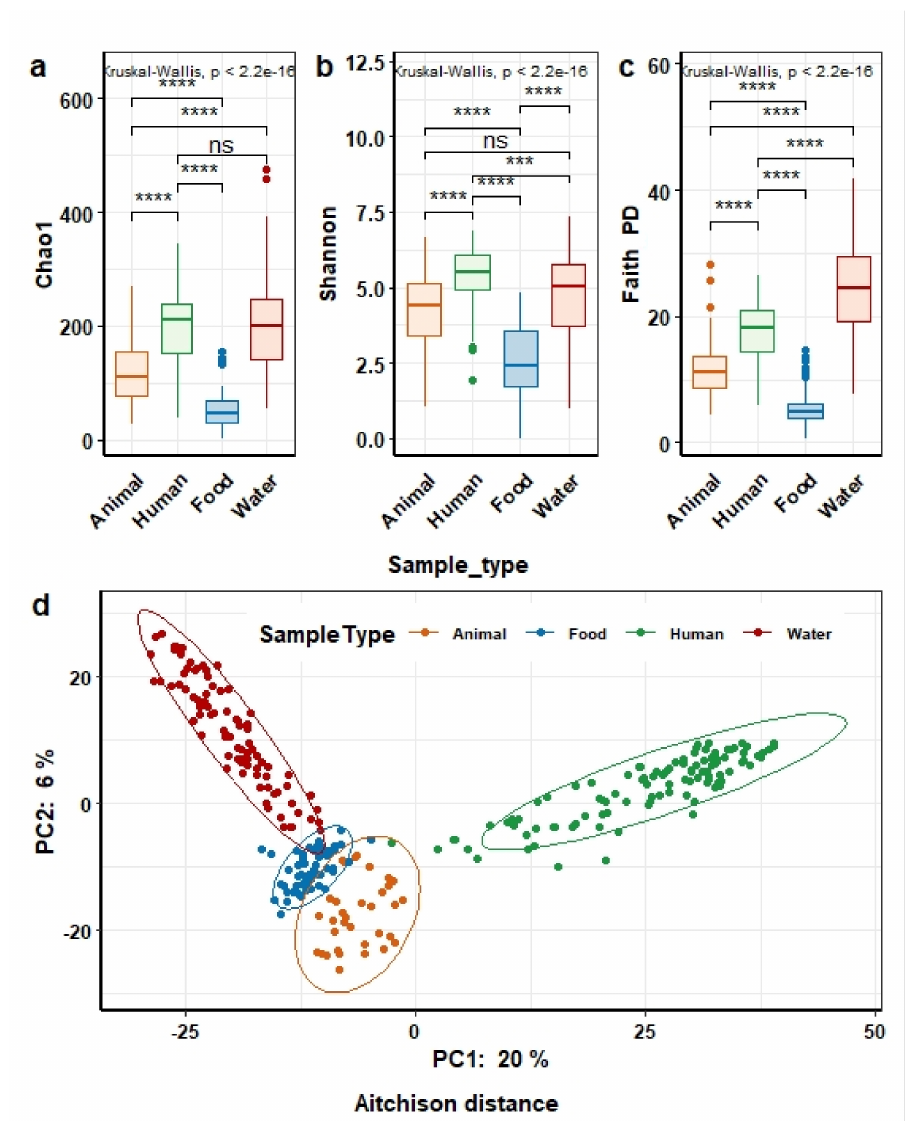
Figure 6. Microbial composition of human and animal gut, water, and food. Differences in estimated microbial richness (Chao1) ( a ) and diversity (Shannon ( b ) and Faith’s PD ( c )) across sample types. Kruskal–Wallis test followed by Wilcoxon test for post hoc comparisons of four sample types (humans, animals, food, and water). *** p < 1 × 10 − 3 , **** p < 1 × 10 − 4 . ( d ) Principal component analysis (PCA) based on Aitchison distance. Each point represents the microbial community structure of an individual animal stool (orange), human stool (green), food (dark blue), and water (red) sample. (PERMANOVA test, p value < 1 × 10 − 3